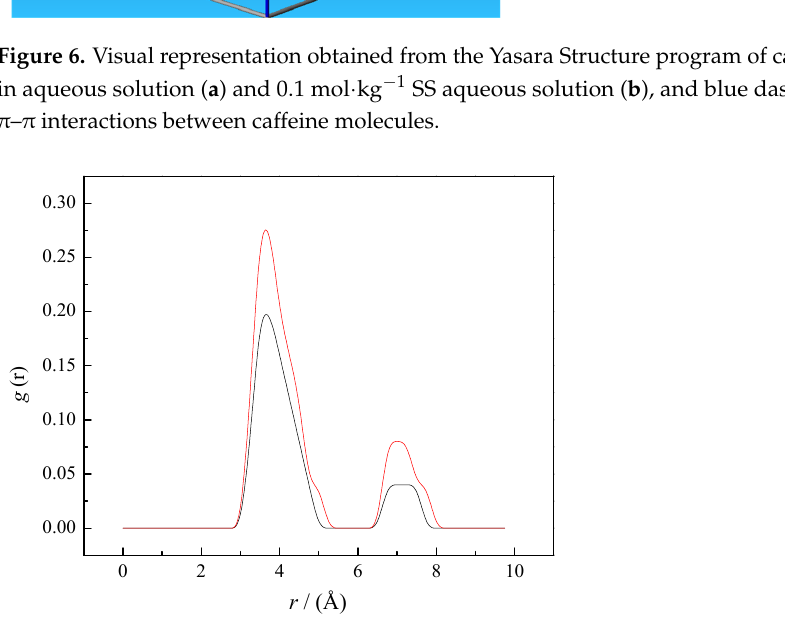
Figure 7. RDFs for the caffeine–caffeine center of mass (black line—aqueous solution, red line—0.1 mol · kg − 1 SS aqueous solution). The lines represent the radial distribution functions obtained from MD simulations’ trajectories.